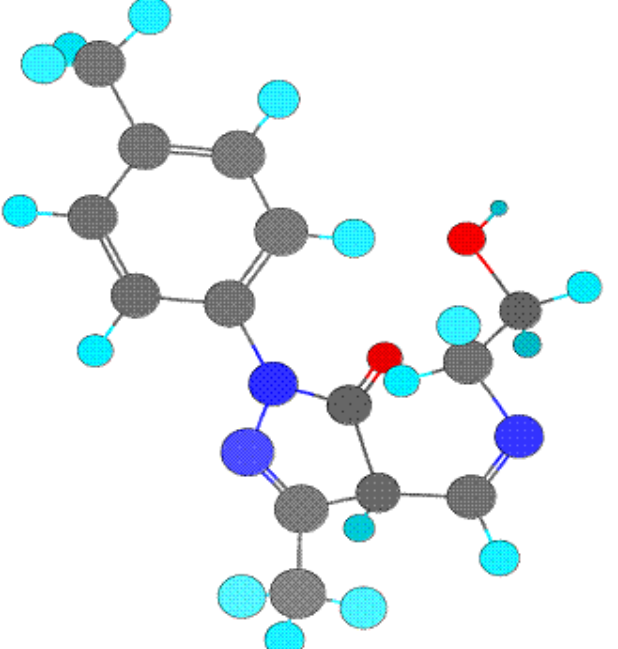
Figure 2. Ball and stick model schiff base ligand (III)